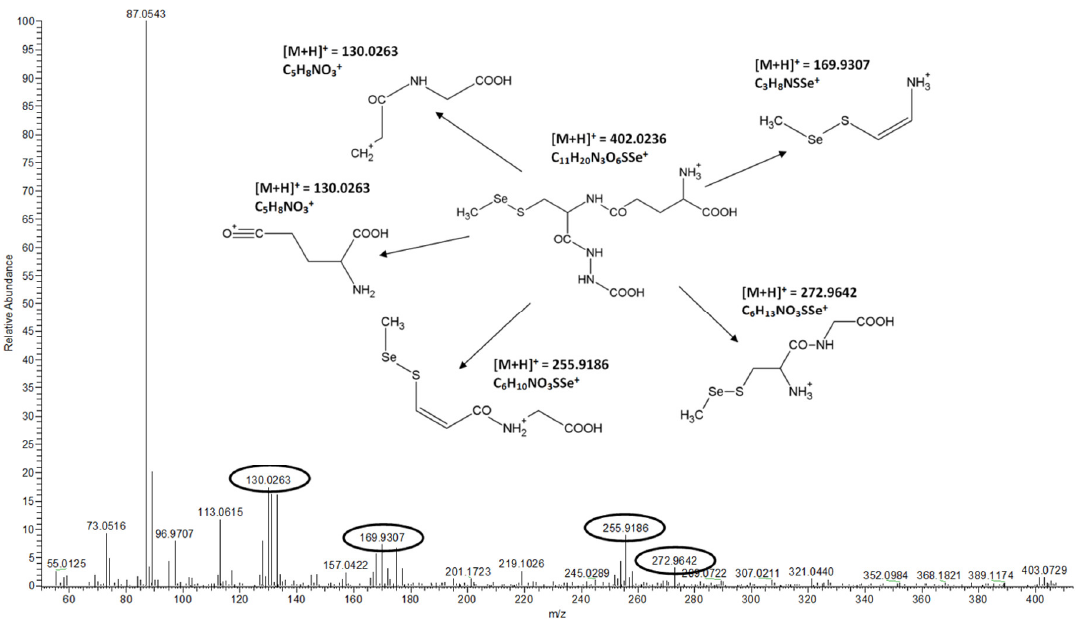
Figure 5. Fragmentation spectrum for ion with m / z = 402.0236 and fragmentation pathway.